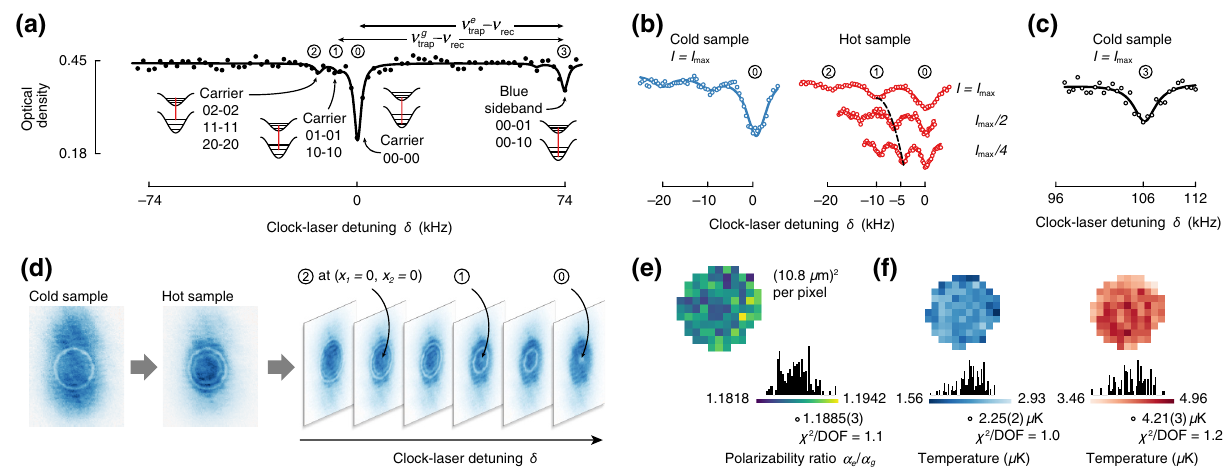
FIG. 5. The local clock spectroscopy of carrier and sideband transitions in nonmagic lattices. (a) A sparse clock-sideband spectrum in a 2D nonmagic optical lattice. The solid line is a fit to a multipeak Lorentzian function, in which the peak locations are fixed at the expected detunings. (b) A more finely resolved spectrum covering a detuning range of the carrier transitions for the samples with two different temperatures, one colder (left) and the other hotter (right). To maximize the splitting, we increase ν t to approximately 109 kHz from approximately 77 kHz [at which (a) is taken]. For the hotter samples, we vertically stack three spectra taken at different lattice intensities I , at which I max results in ν t (cid:5) 109 kHz. The dotted line is a guide to the eye for easier visualization of the carrier splitting frequency as a function of the lattice intensity. (c) A blue-sideband spectrum taken at ν t (cid:5) 109 kHz. (d) A comparison of the absorption images of the cold and hot samples after the clock excitation at a fixed detuning (left) and a series of images of the hot sample as a function of the detuning. (e) The per-pixel polarizability ratio and weighted histogram. (f) Temperature maps of cold (left) and hot (right) samples with weighted histograms, where DOF stands for the degrees of freedom of the corresponding fit. the peaks constrained to be the same. From the fit, we determine the frequency splitting (cid:8)δ between the carri- ers for each averaged pixel and combine this value with ν e = ν e + (cid:8)δ . The to obtain ν g for every pixel, ν g t t t t